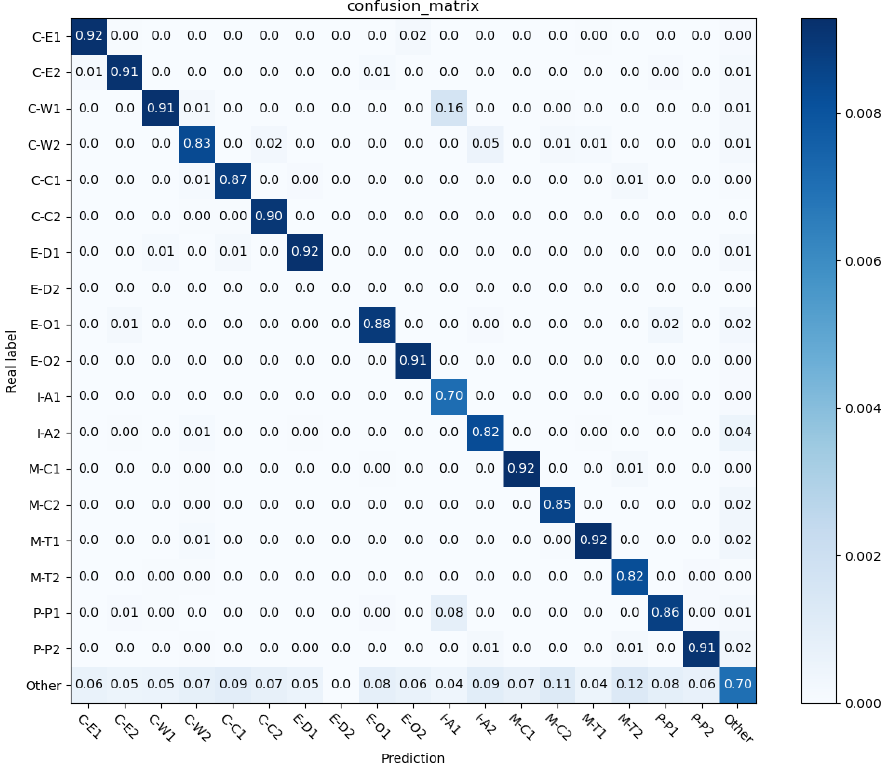
Figure 7. A total of 19 confusion matrices of classified (differentiated direction)